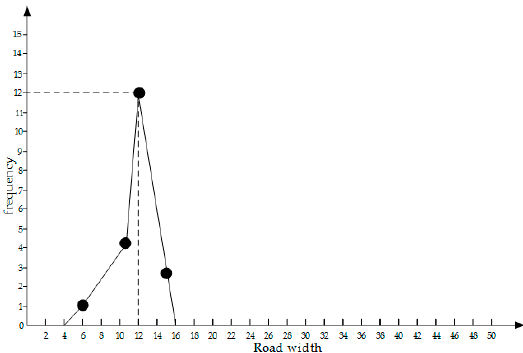
Figure 9. Probability statistics of road width.